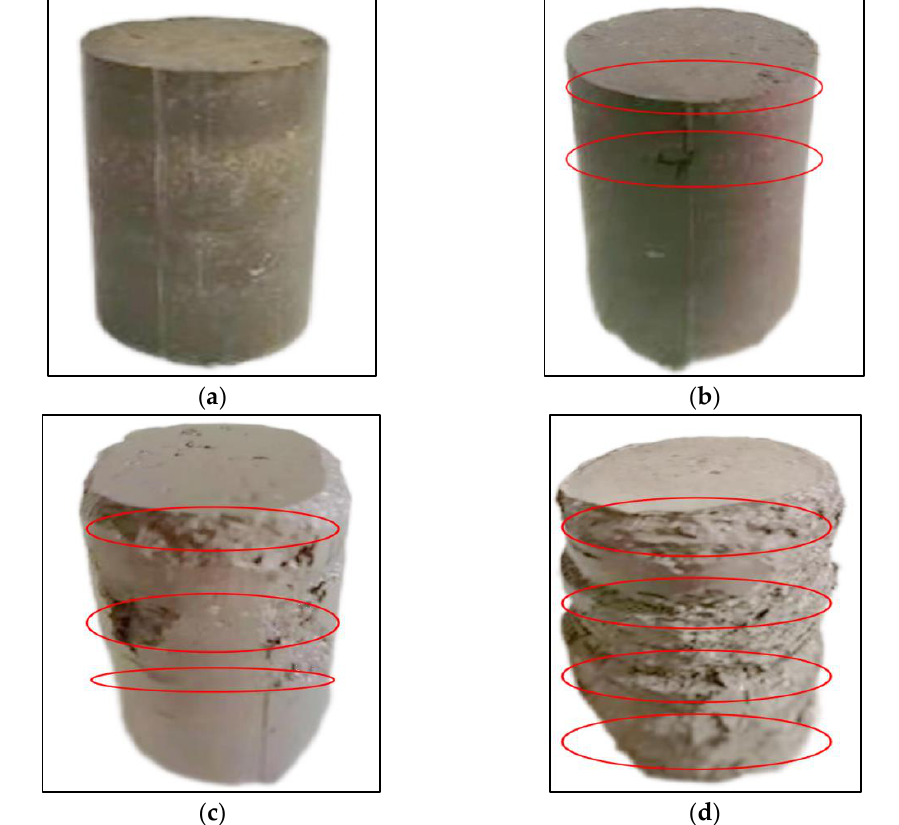
Figure 26. Morphology of the solidified waste silt before and after dry-wet cycles when w g = 8%: ( a ) N dw = 0, ( b ) N dw = 1, ( c ) N dw = 3, ( d ) N dw = 6.